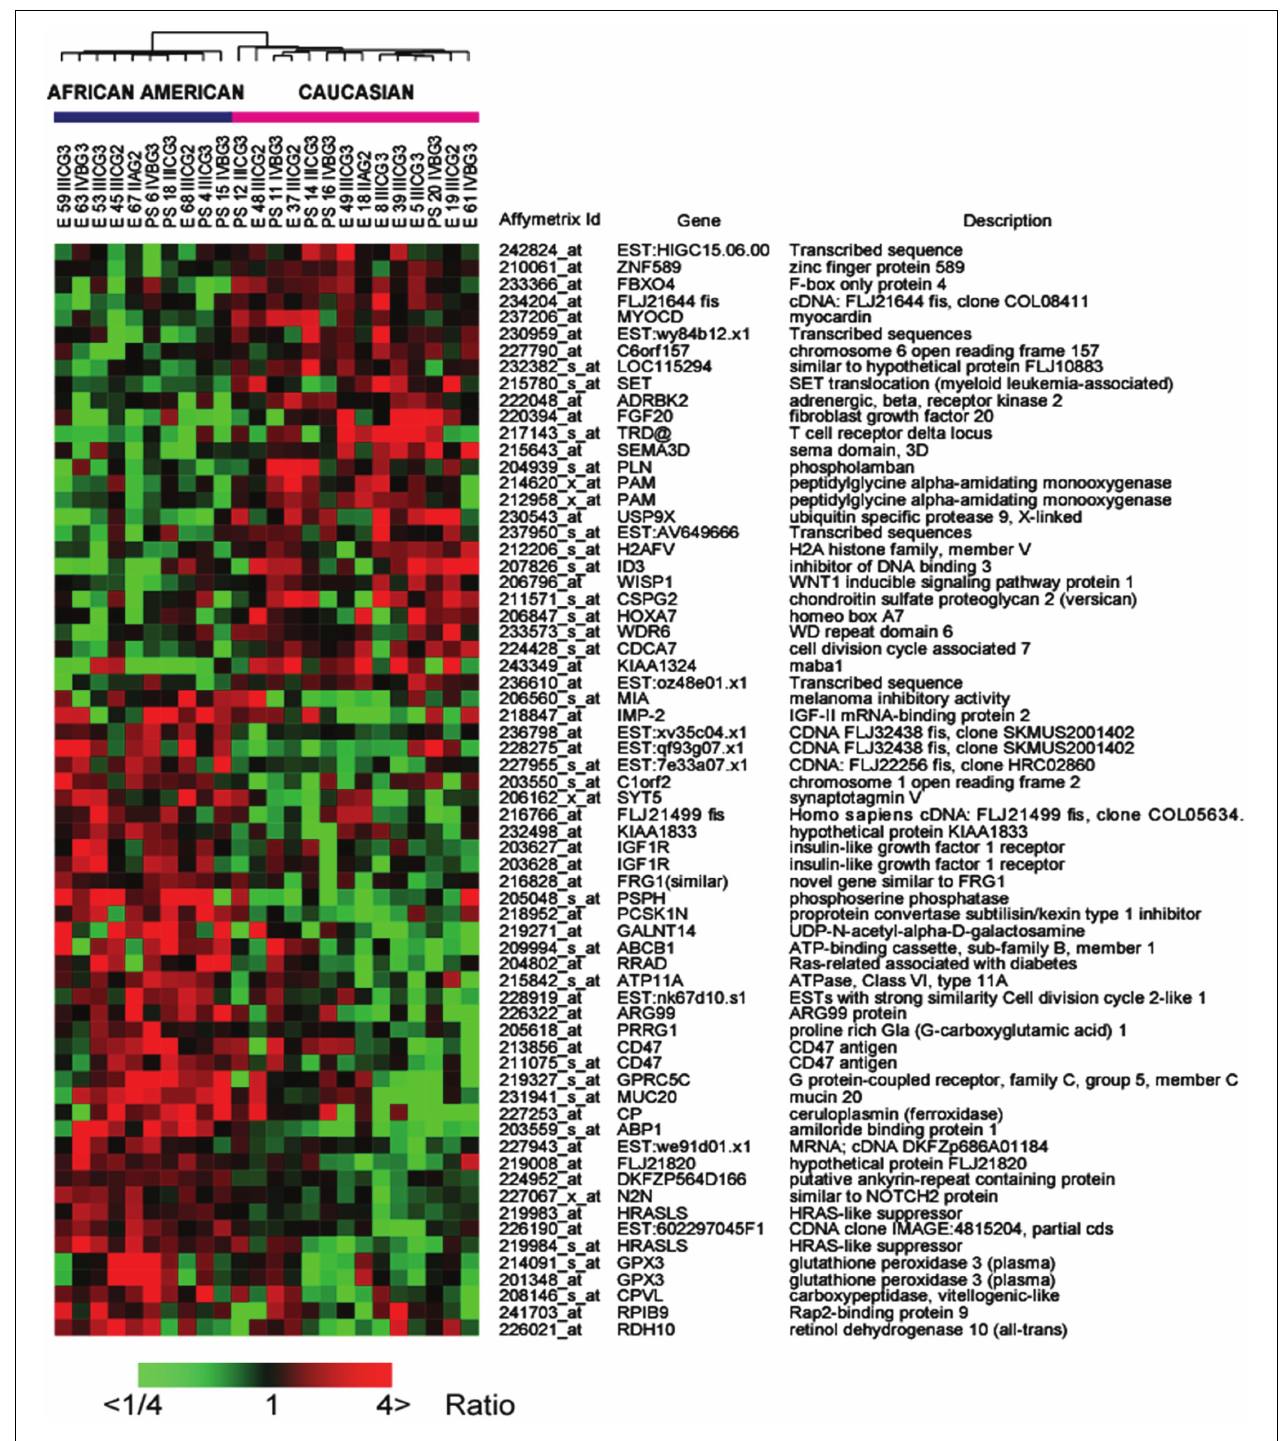
FIGURE 2 | Heat map of 66 transcripts differentially expressed betweenAfrican-American and Caucasian by twofold and p <0.005. Expressions shown are mean centered.The red indicates increased and green down-regulated expression while black indicates mean value.